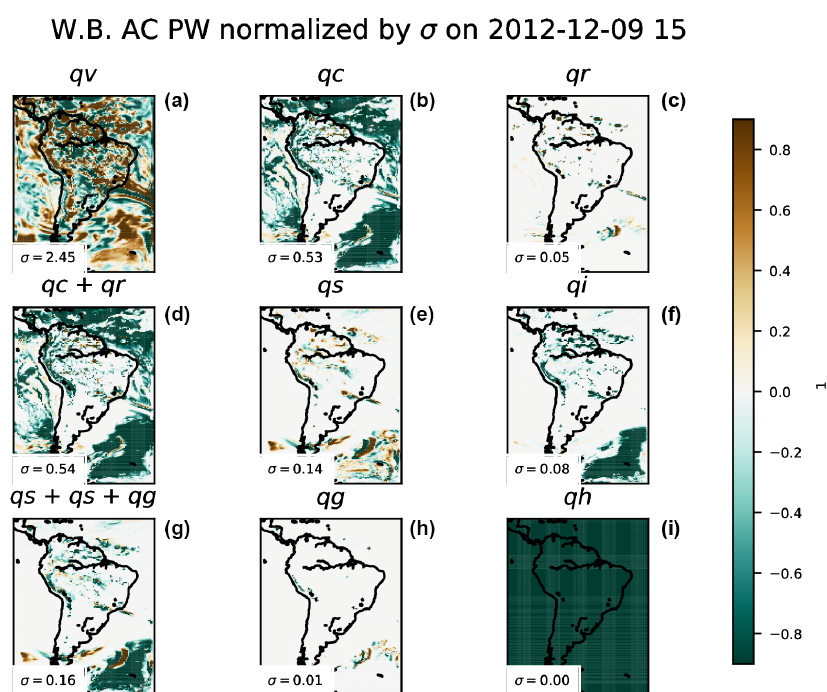
Figure 10. Normalized (with the spatial standard deviation of the mapped values, σ ) water budget 3h accumulated vertically integrated total tendency PW at a given time, for water vapor (qv, a ), cloud (qc, b ), rain (qr, c ), water condensed species (qc+qr, d ), snow (qs, e ), ice (qi, f ), water solid species (qs+qi+qg, g ), graupel (qg, h ), and hail (qh, i ). Numbers in the lower left corner of the panels correspond to the standard deviation ( σ in millimeters) value used for the normalization.